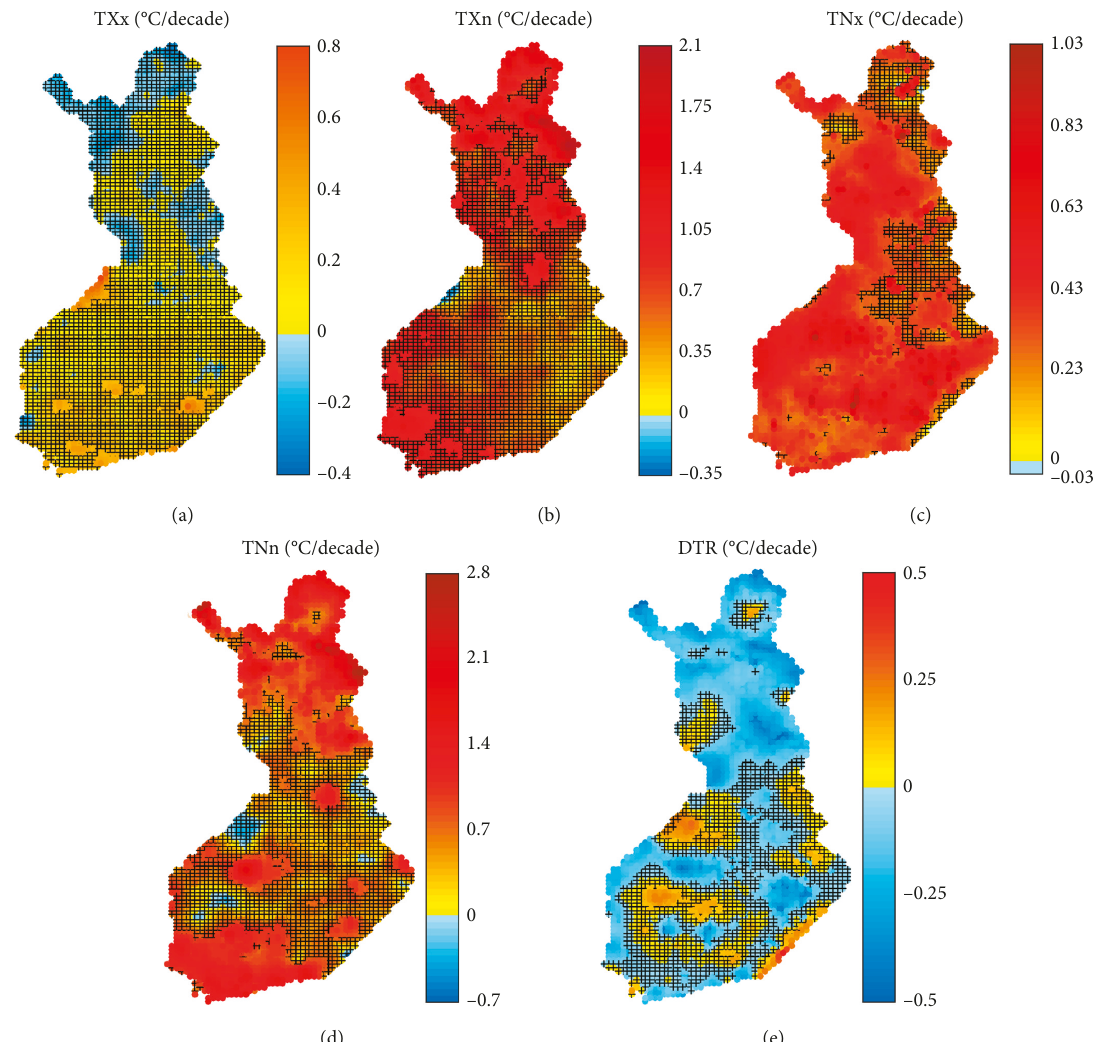
Figure 6: Spatial distribution maps of trends (/decade) in (a) TXx, (b) TXn, (c) TNx, (d) TNn, and (e) DTR in Finland during 1961–2011. The stippling indicates areas where the trends are statistically insignificant ( p